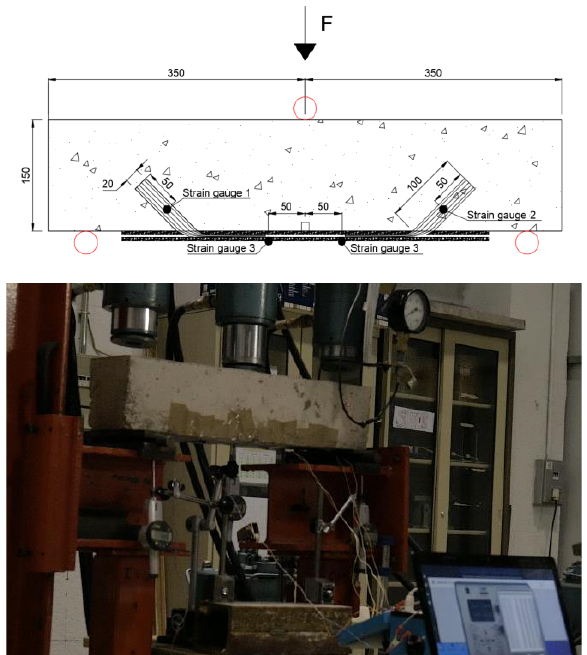
Figure 5. Test set up and instrumentation arrangement.